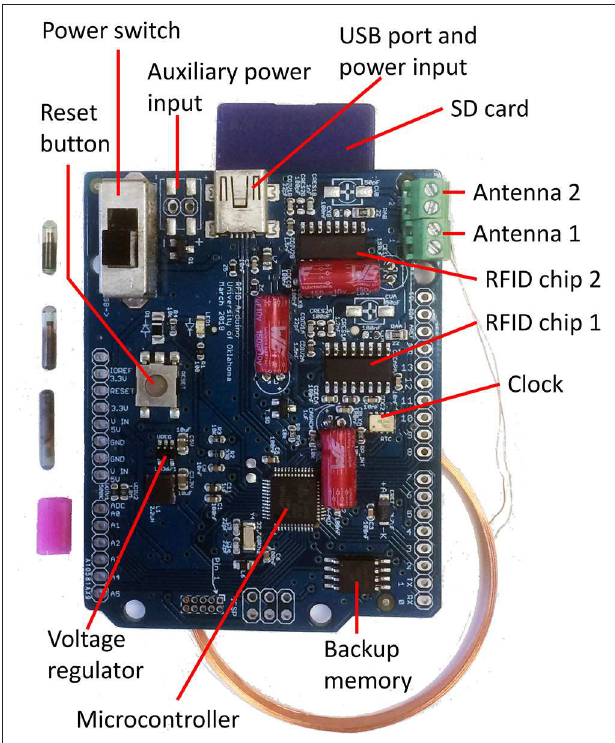
FIGURE 1 | The RFID reader circuit board with key components labeled. The dimensions of the board are those of a standard Arduino: 68.58 × 53.34mm. Four PIT tags are shown to the left of the circuit board. The bottom tag is an RFID leg